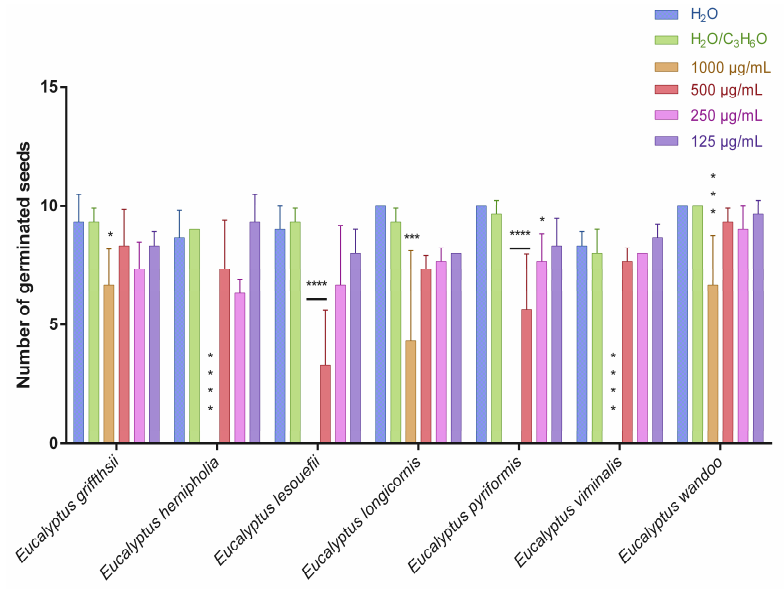
Figure 5. Number of germinated seeds of Lolium multiflorum seeds after treatment with different concentrations (125–1000 µg/mL) of Eucalyptus essential oils measured 120 h after sowing. Results are the mean ± standard deviation ( n = 3) of three independent experiments. * p < 0.05; *** p < 0.001, **** p < 0.0001 compared to control (ANOVA followed by Dunnett’s multiple comparison test).